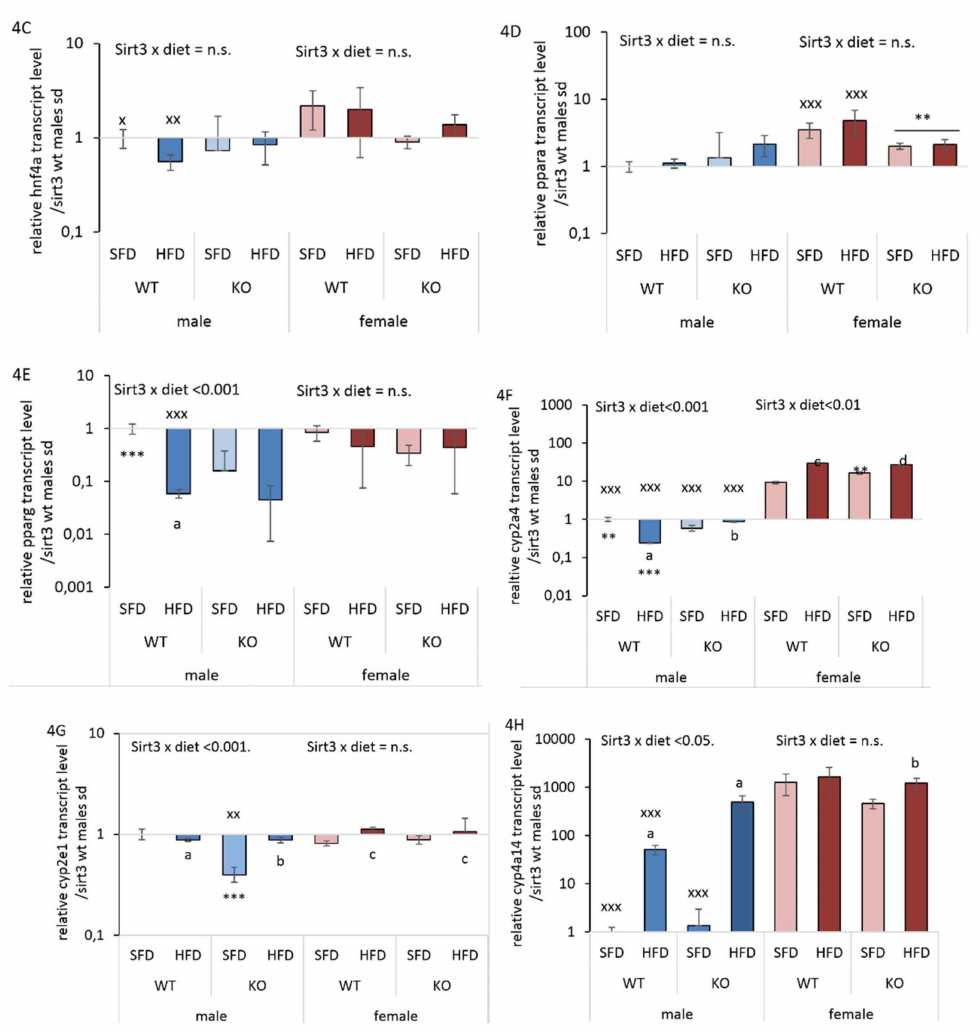
Figure 4. Gene expression of hnf4 α , ppar α , ppar γ , cyp2a4, cyp2e1 , and cyp4a14 in the livers of Sirt3 wild-type (WT) and knockout (KO) mice fed with a standard fat diet (SFD) or a high fat diet (HFD) for 10 weeks. ( A ) A heatmap of the mRNA levels of hnf4 α , ppar α , ppar γ , cyp2a4 , cyp2e1 , and ( B ) cyp4a14 genes. The color of the squares on the heat map corresponds to the mean value of the log fold change from three biological and three technical replicates. ( C ) A graphical display of hnf4a mRNA level. Males: no changes. Females: no changes. Males vs. females: SFD-fed ( x p < 0.05) and HFD-fed ( xx p < 0.01). ( D ) A graphical display of ppar α mRNA levels. Males: no changes. Females: KO vs. WT mice (** p < 0.01). Males vs. females: WT mice ( xxx p < 0.001). ( E ) A graphical display of ppar γ mRNA levels. Males: HFD-fed vs. SFD-fed WT mice ( a p < 0.001); SFD-fed WT vs. KO mice (*** p < 0.001). Females: no changes. Males vs. females: HFD-fed WT mice ( xxx p < 0.001). ( F ) A graphical display of cyp2a4 mRNA levels. Males: HFD-fed vs. SFD-fed WT mice ( a p < 0.001); HFD-fed vs. SFD-fed KO mice ( b p < 0.01); SFD-fed WT vs. KO mice (** p < 0.01) and HFD-fed WT vs. KO mice (*** p < 0.001); Females: HFD-fed vs. SFD-fed WT ( c p < 0.001) and KO mice ( d p < 0.01); SFD-fed KO vs. WT mice (** p < 0.01); Males vs. females: xxx p < 0.001. ( G ) A graphical display of cyp2e1 mRNA levels. Males: HFD-fed vs. SFD-fed WT mice ( a p < 0.05); HFD-fed vs. SFD-fed KO mice ( b p < 0.001); SFD-fed KO vs. WT mice (*** p < 0.001). Females: HFD-fed vs. SFD-fed mice ( c p < 0.01). Males vs. females: SFD-fed KO mice ( xx p < 0.01). ( H ) A graphical display of cyp4a14 mRNA levels. Males: HFD-fed vs. SFD-fed mice ( a p < 0.001). Females: HFD-fed vs. SFD-fed KO mice ( b p < 0.01). Males vs. females: WT mice and SFD-fed KO mice ( xxx p < 0.001). β -actin was used for normalization. The data are shown as mean ± SD. n = 3 per group in technical